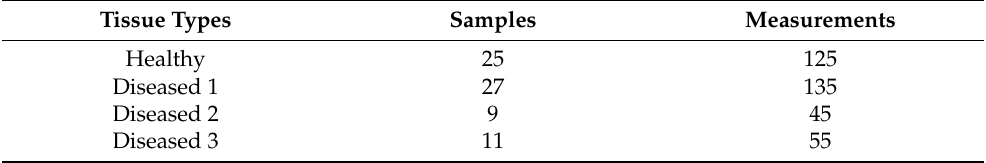
Table 1. Sample and measurement count.